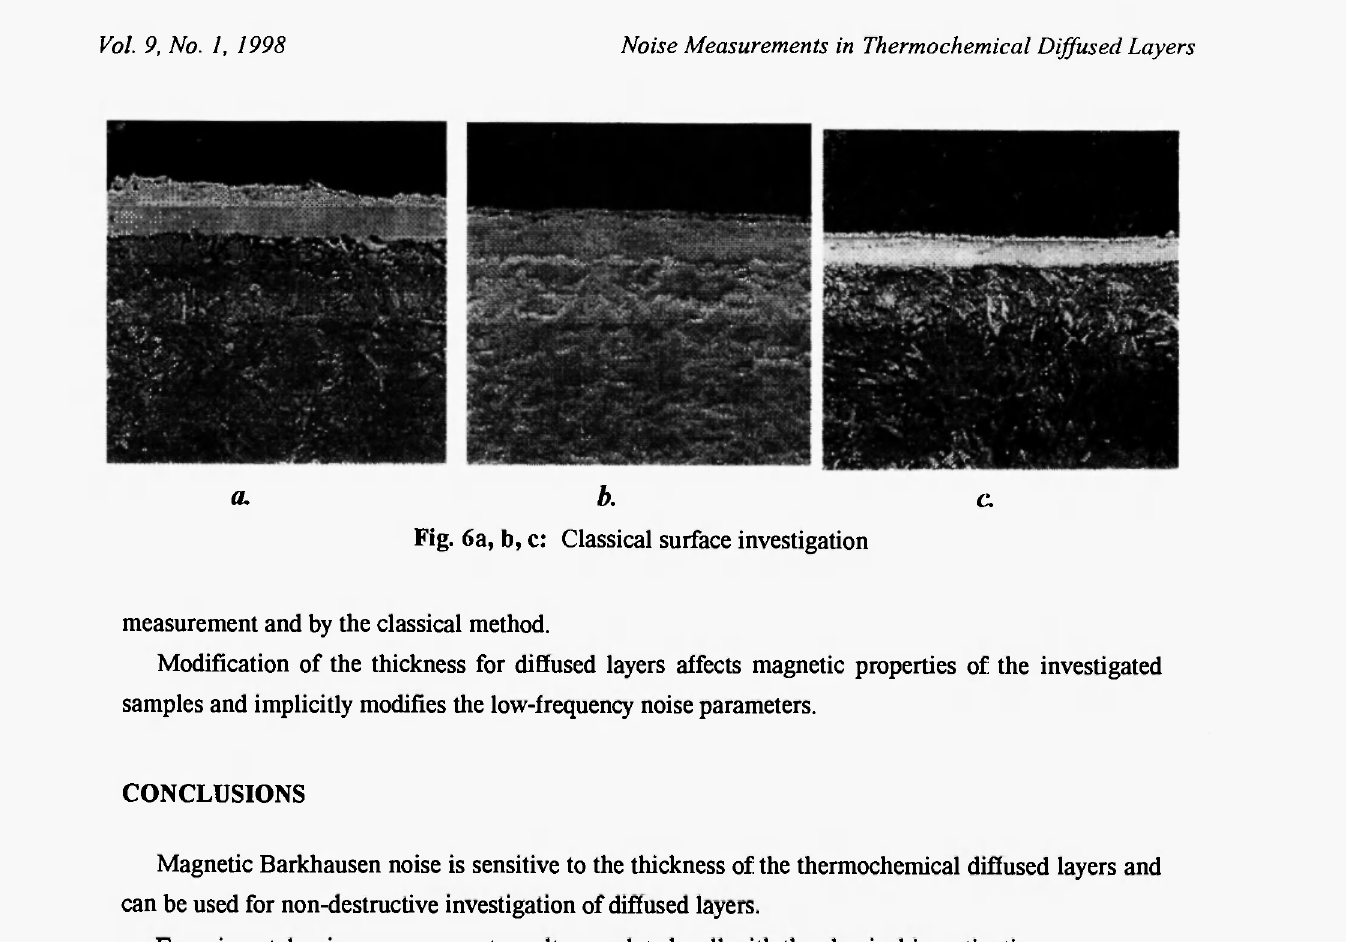
Fig. 6a, b, c: Classical surface